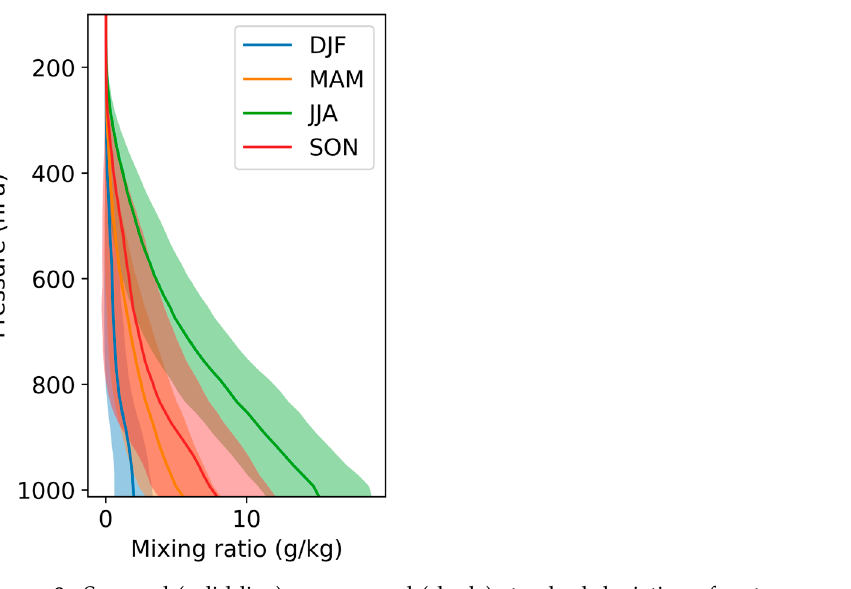
Figure 9. Seasonal (solid line) average and (shade) standard deviation of water vapor profiles for 15 stations in 2022 (DJF: Dec.-Jan.-Feb., MAM: Mar.-Apr.-May, JJA: Jun.-Jul.-Aug., SON: Sep.-Oct.-Nov).